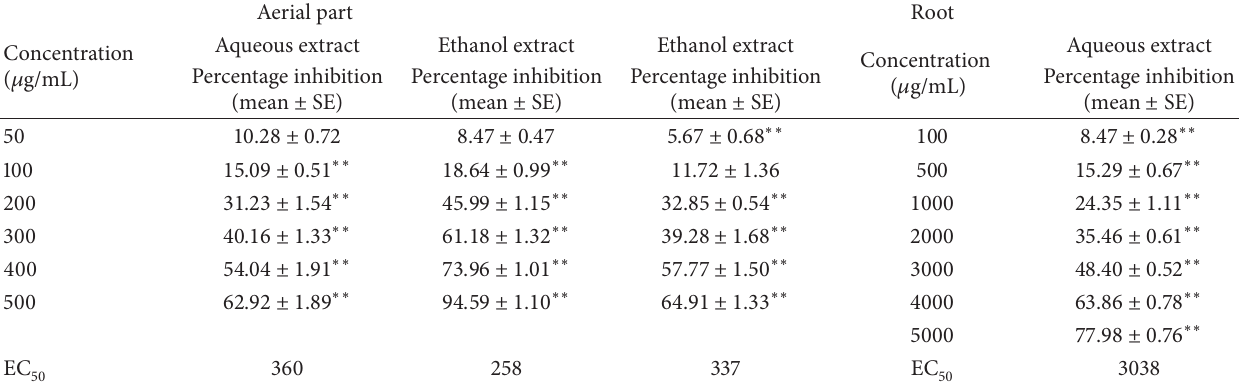
Table 1: DPPH free radical scavenging activity of P. fraternus aqueous and ethanolic extracts of aerial part and root. Aerial part